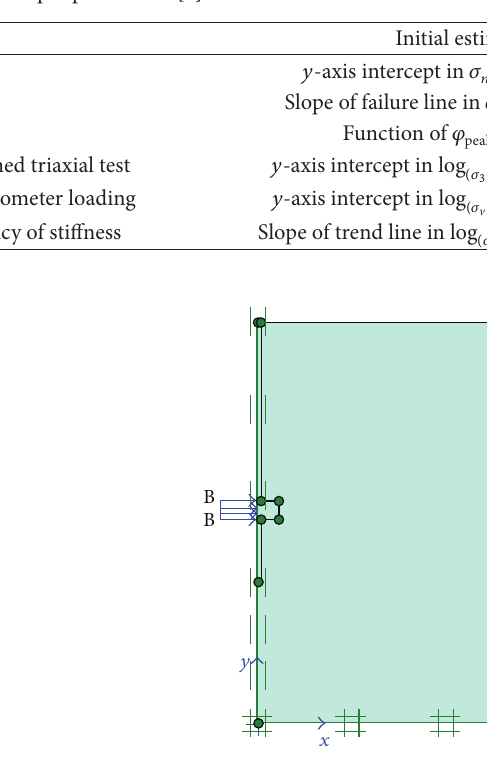
Table 1: HS input parameters [3].